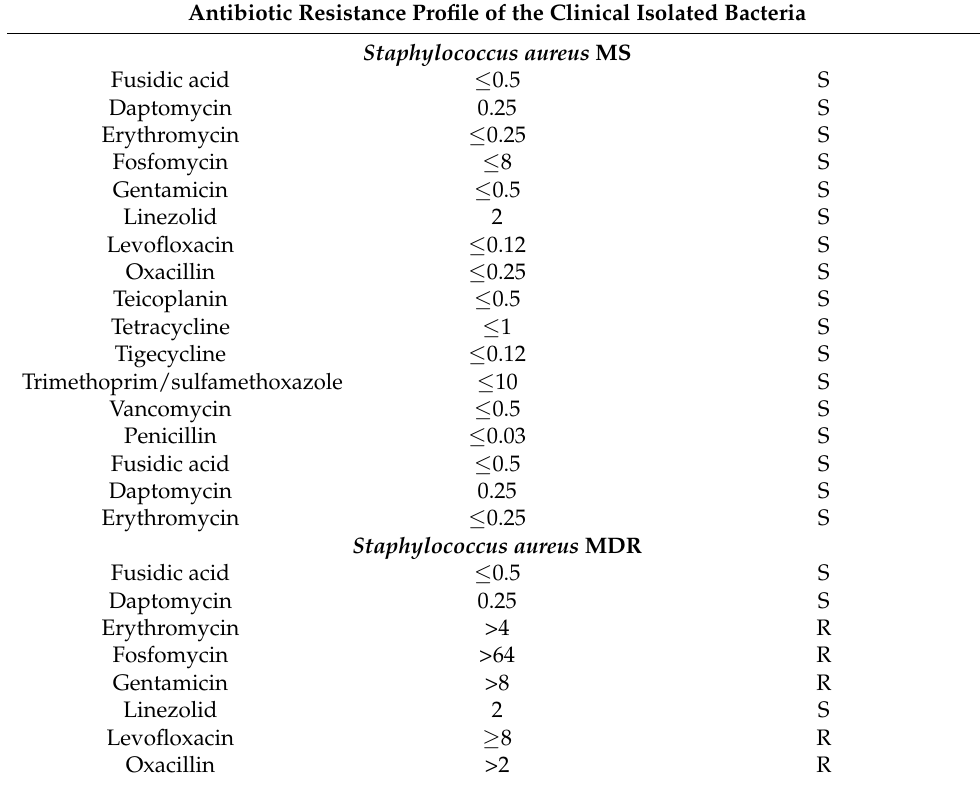
Table 2. Antibiotic resistance profile of the clinical isolates: S. aureus MS, S. aureus MDR, E. faecalis MS, E. faecalis MDR, E. coli MS, E. coli MDR, K. pneumoniae MS, and K. pneumoniae MDR. Antibiotic Resistance Profile of the Clinical Isolated